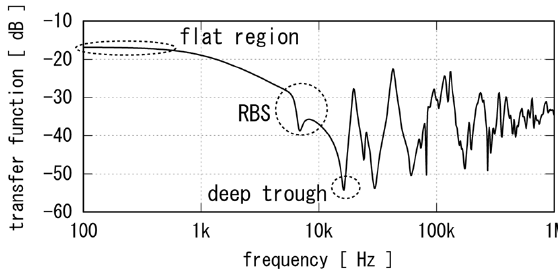
Figure 3. Example of TF in IIW measurement.